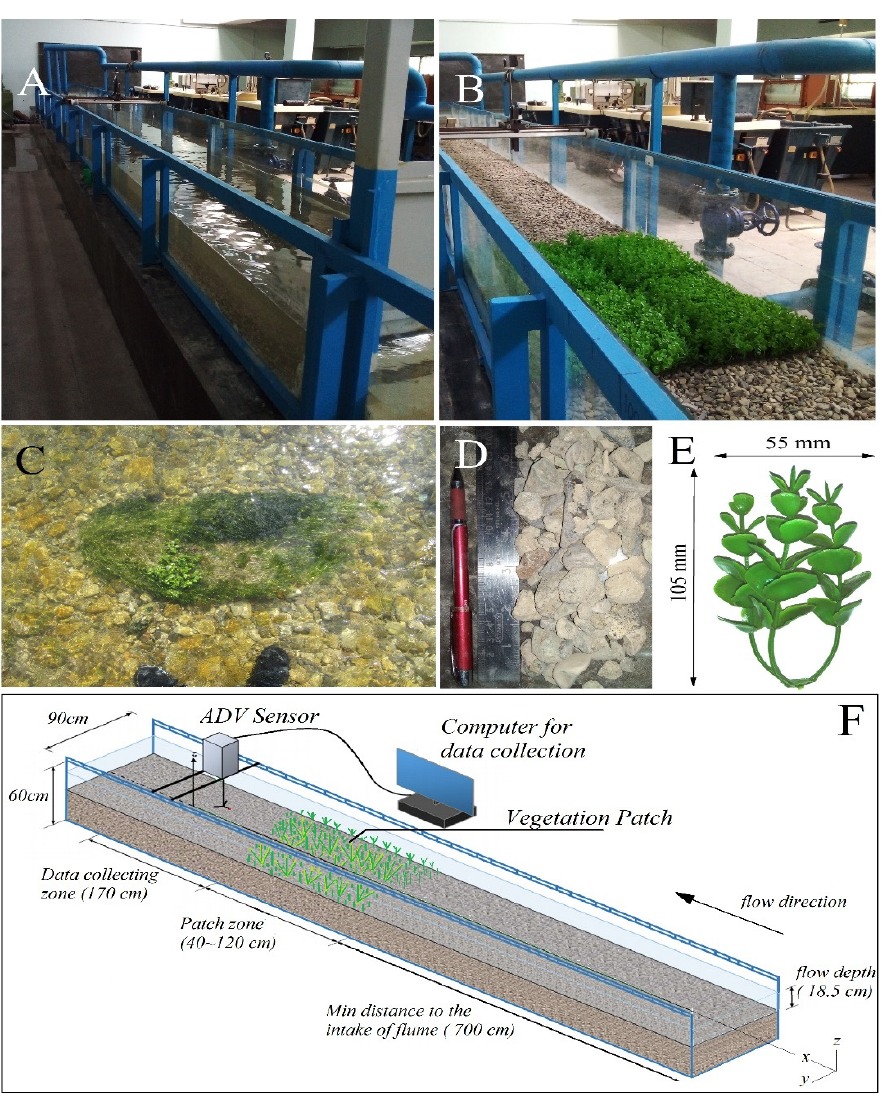
Figure 3. ( A ) The layout of the experimental device, ( B ) a sample of vegetation patches (120 × 90 cm, D V /D C = 1), ( C ) a sample of a vegetation patch in a natural gravel-bed river (Marbor River, Iran), ( D ) a sample of bed materials, ( E ) a single synthetic plant used to simulate patch, and ( F ) a sketch of the experimental set-up (Not to scale).